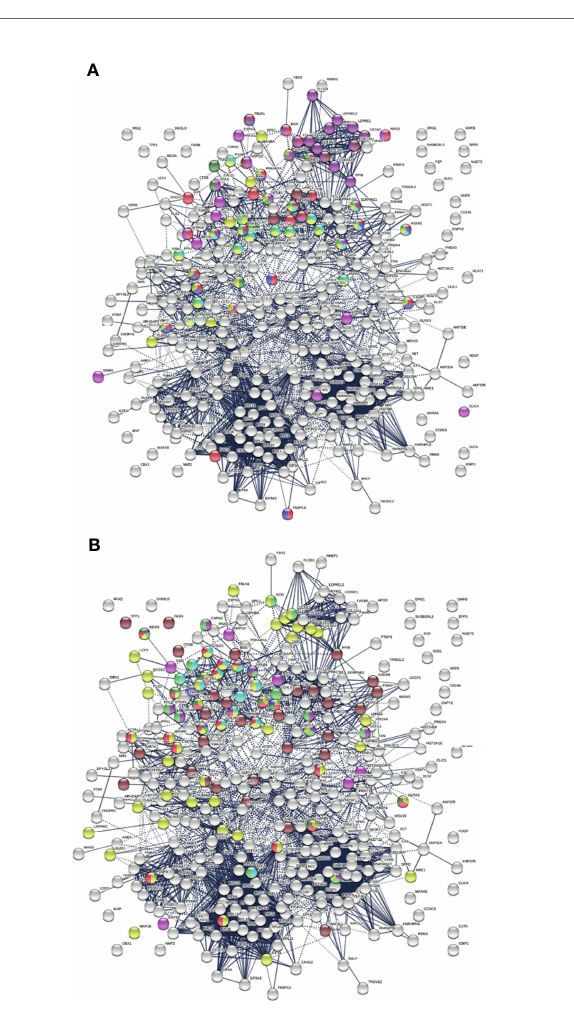
FIGURE 4 | (A) Nervous system-related proteins among COVID-altered proteins. Colored proteins are involved in axon guidance (62 proteins, aqua), axon growth cone (25 proteins, blue), myelin sheath (26 proteins, red), neuron projection (32 proteins, green) and neuron projection extension (7 proteins, dark green), neuronal cell body (16 proteins, gold), peripheral nervous system axon regeneration (3 proteins, brown), cerebellar Purkinje cell layer development (4 proteins, amber), and olfactory bulb (23 proteins, pink). (B) Neurological disease-related proteins among proteins altered in COVID. Colored are proteins found in neuronal infection with Japanese encephalitis virus (23 proteins, blue), neuroblastoma (21 proteins, red), glioblastoma (22 proteins, pink), neurodegeneration in Down syndrome (26 proteins, dark green), Alzheimer disease (22 proteins, aqua), schizophrenia (24 proteins, amber), cerebral ischemia induced neurodegenerative diseases (17 proteins, dark purple), Parkinson disease (17 proteins, brown), and neurodegeneration (21 proteins, green).